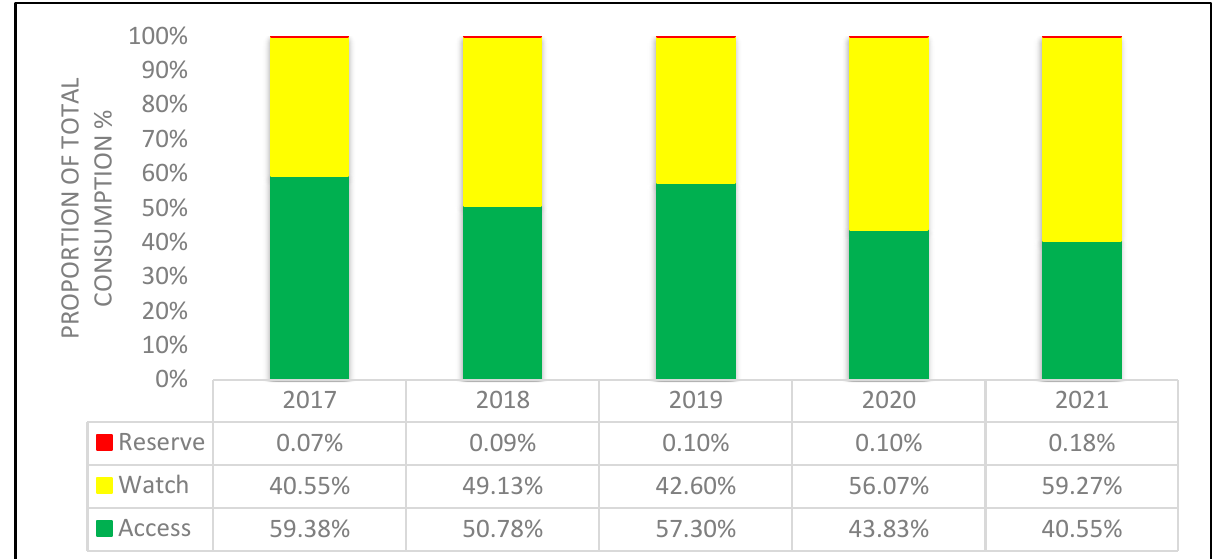
Figure 1. Total consumption of antibiotics for systemic use according to WHO AWaRe classification, percentage by class from 2017 to 2021. The amoxicillin index decreased from 20% in 2017 to 11% in 2021 (Table